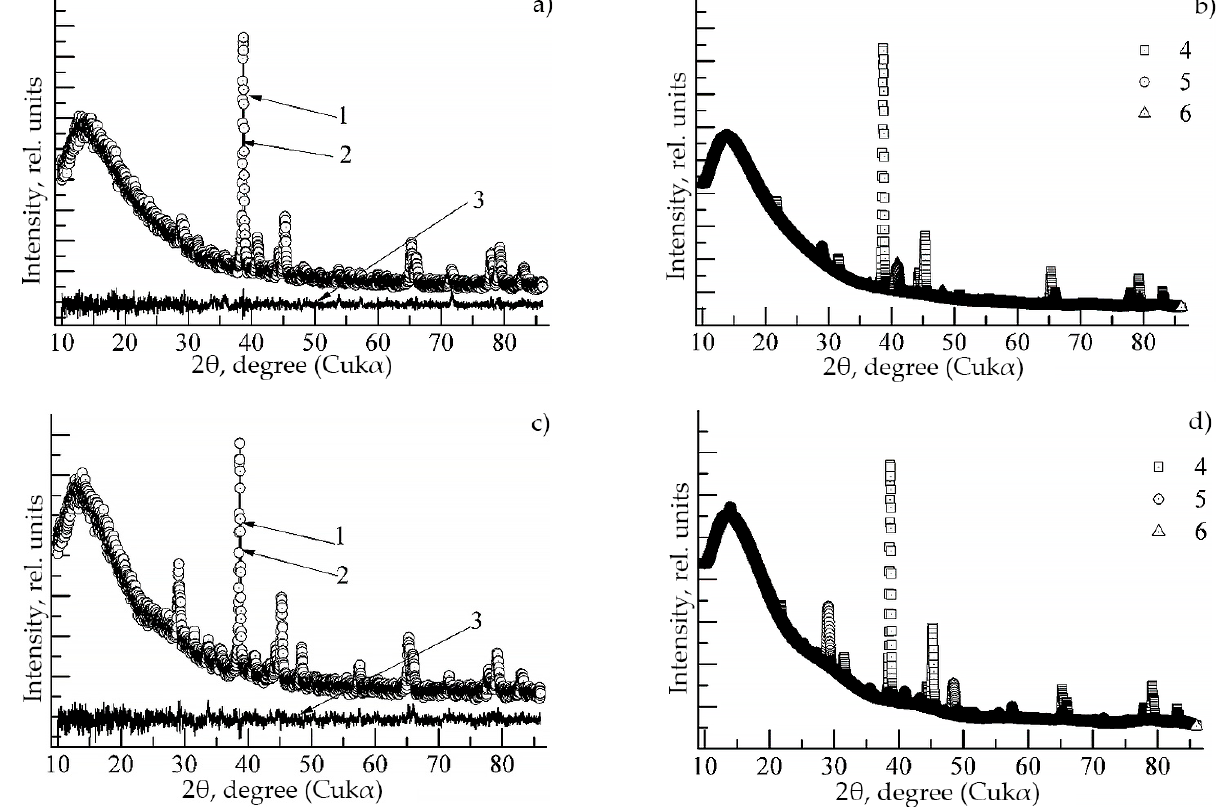
Figure 1. Diffraction patterns of alloys: TAD ( a , b ); TAH ( c , d ). The figures indicate: 1—experiment, 2—total model intensity, and 3—difference between the intensities. Numbers 4, 5 and 6 are contributions to the integral intensity of single phases.